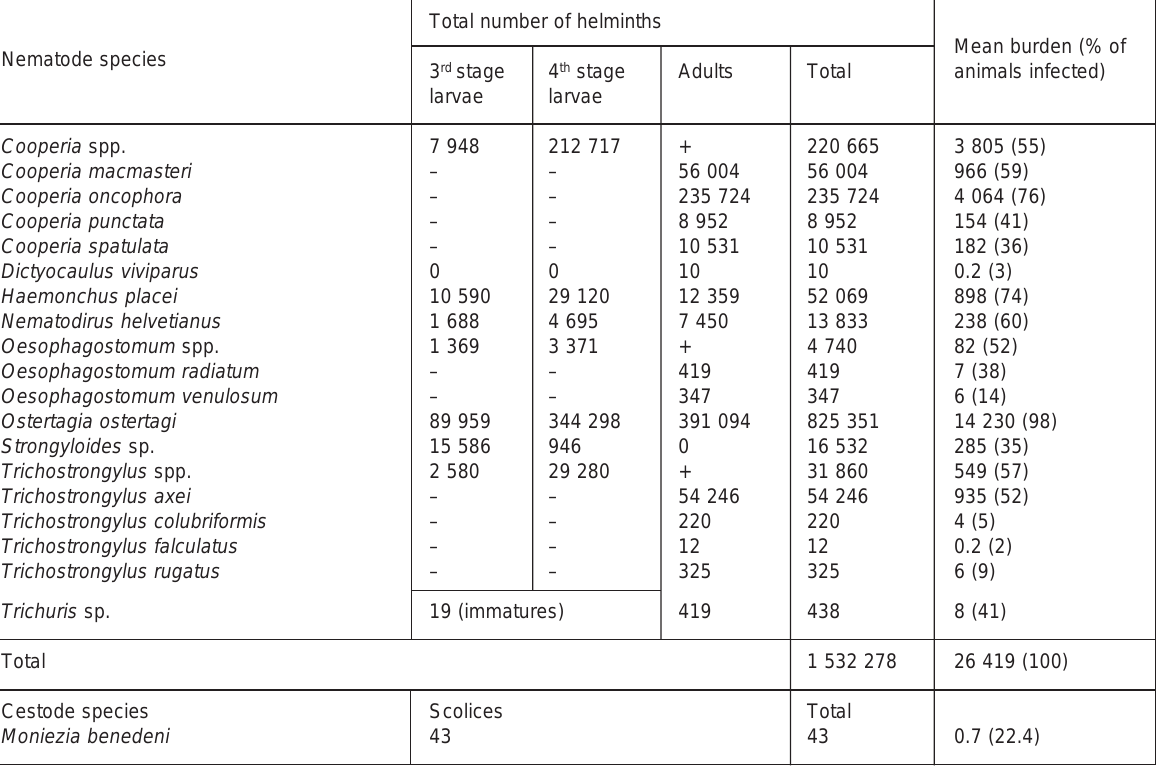
TABLE 2 Helminths collected from 58 tracer bull calves on Kikuyu grass pastures on the farm “Glen Dye”, Eastern Cape